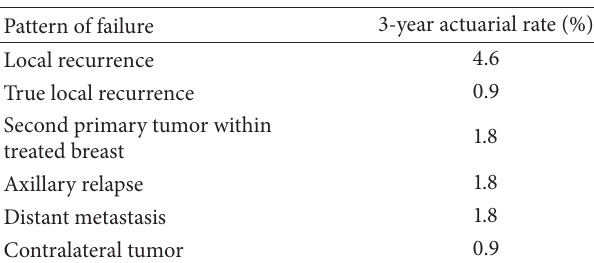
Table 3: The 3-year actuarial rates of recurrence. Data of the 109 patients with at least 36 months of